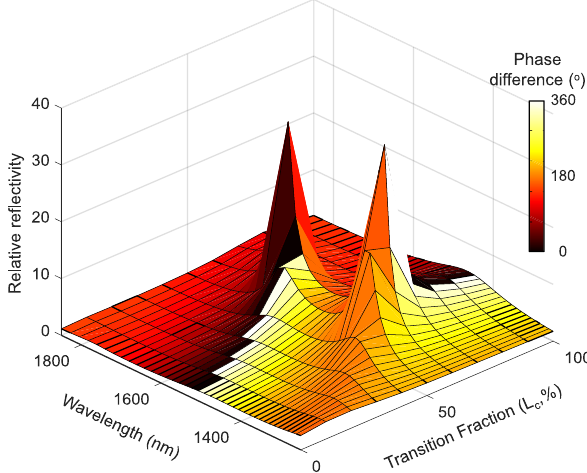
Figure 6: High-performance behavior of the metasurface in Figure 1 in optical amplitude modulation. (a) The IL and ER diagrams for the proposed modulator in which ON- and OFF-states correspond to the L 0 c and L 60 c , respectively. (b) The FoM and MD curves obtainedbynumericalsimulationsjustifythe unprecedented response of the modulator in the telecommunication band.